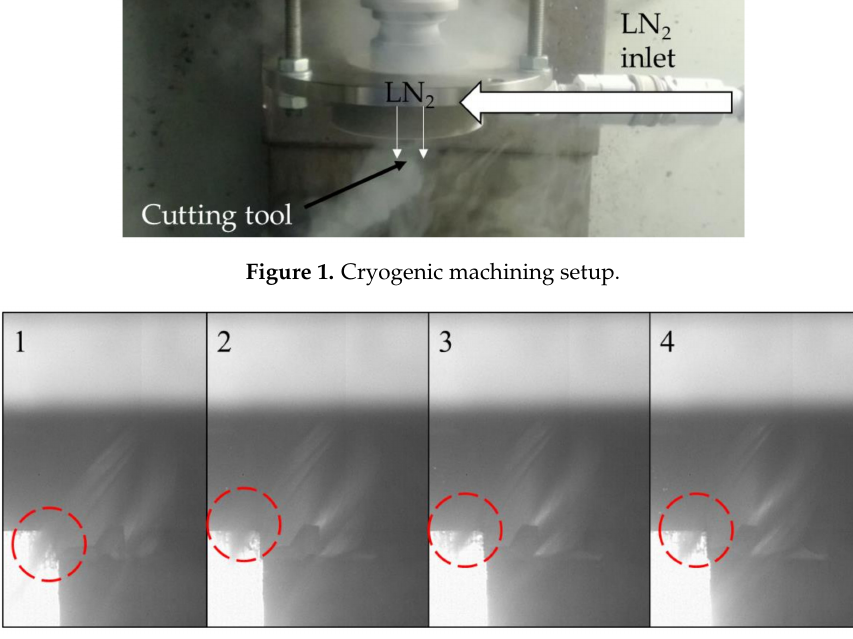
Figure 2. Slow-motion time laps of cryogenic machining showing the delivery of LN 2 into the cutting zone through the tool’s